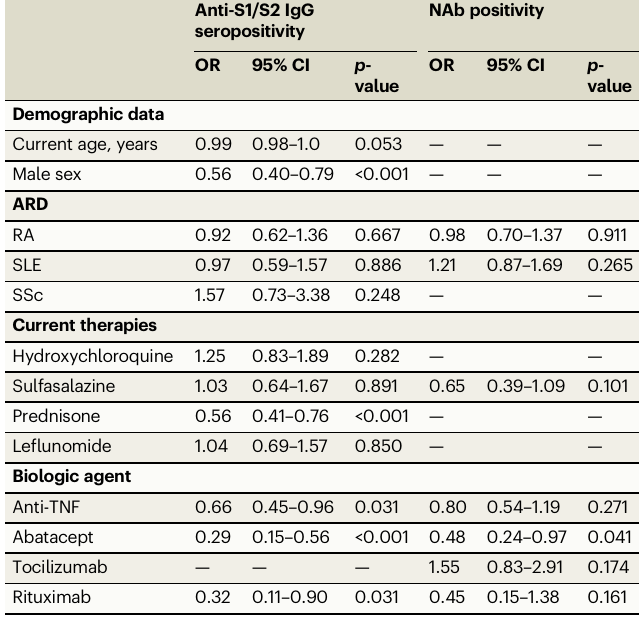
Table 4 | Multivariate analyses of characteristics of auto- immune rheumatic diseases (ARD) patients without and with seropositivity (SP) for anti-SARS-CoV-2 S1/S2 IgG antibodies and without and with neutralizing antibodies (NAb) 6 months after second dose of Sinovac-CoronaVac vaccination (D210)